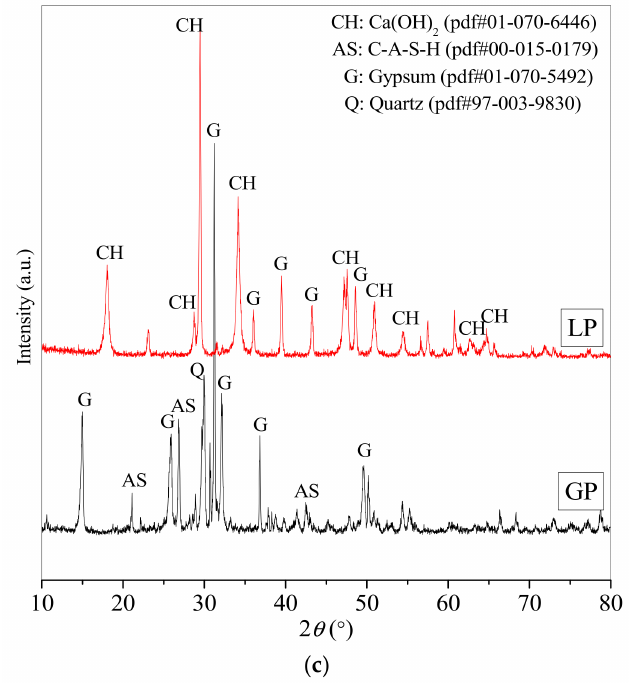
Figure 2. The XRD patterns of raw materials: ( a ) low-calcium silica–alumina precursors (FAI, FAII, and RM), ( b ) high-calcium-based slags (CS, SR, GBFS, and BRS), and ( c ) two additives (LP and GP).